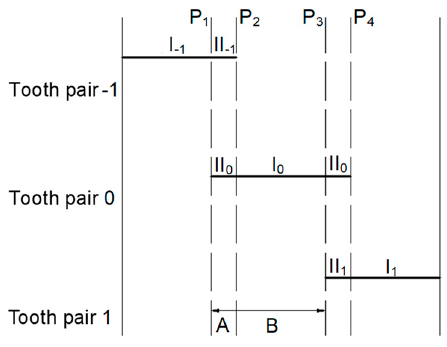
Figure 4. Illustration of gear mesh. The circumferential displacement difference can be calculated by Equation (5) [13]. where subscript i represents the critical position P 1 , P 2 , P 3 and P 4 ; ∆ δ i is the circumferential displacement difference at the critical position; δ im is the circumferential displacement of meshing tooth along the contact line at the critical position. δ iu is the circumferential displacement of the tooth without mesh along the contact line at the corresponding position. When T = 50 Nm, the circumferential displacement difference curves at critical posi- tions of the driving pinion are shown in Figure 5.